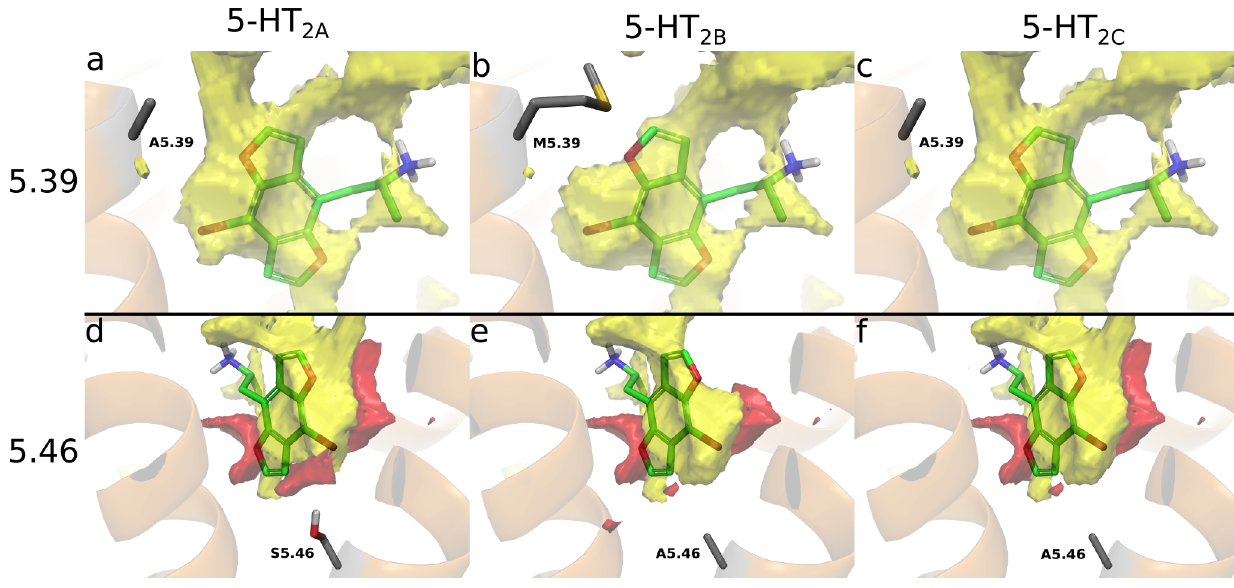
Figure 7. Visualizations of the hydrophobic- (yellow surface) and hydrogen bond acceptor areas (red surface) of the binding sites in 5-HT 2A-C . The maps were produced with SiteMap.[29] The 5.39 methionine in 5-HT 2B (b) reduces the size of hydrophobic pocket. The 2-oxygen matches the hydrogen bond acceptor area for S3.36 interaction whereas the 5-oxygen cannot reach that of S5.43 (left and right sides, respectively, in d-f). 5.46 holds a serine in 5-HT 2A (d) resulting in an hydrogen bond acceptor site close to TMH5, where the other receptor subtypes display hydrophobic